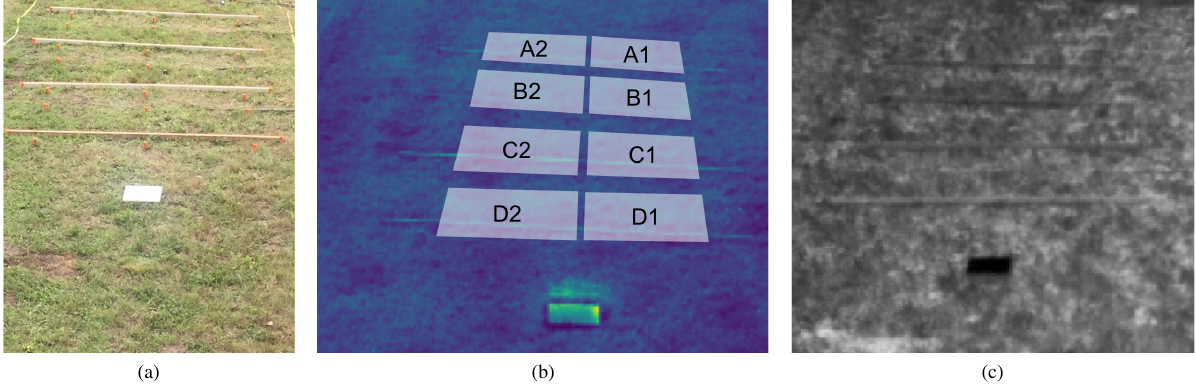
Figure 1. An example of (a) an RGB image, (b) a hyperspectral snapshot, (c) an LWIR image in false colors. The hyperspectral snapshot of 50 × 50 pixels is pan-sharped to 1000 × 1000 only to improve